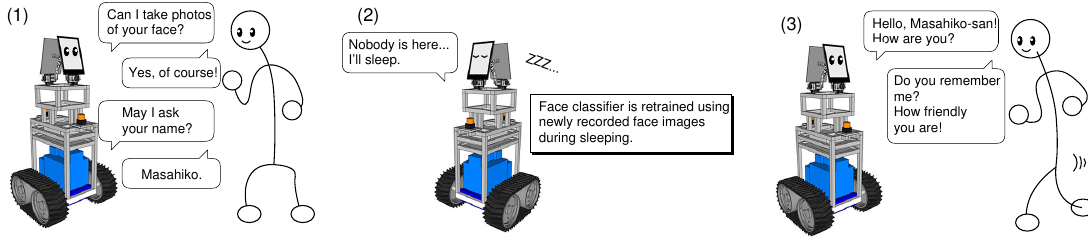
Figure 2. Calling name function based on face memorization.